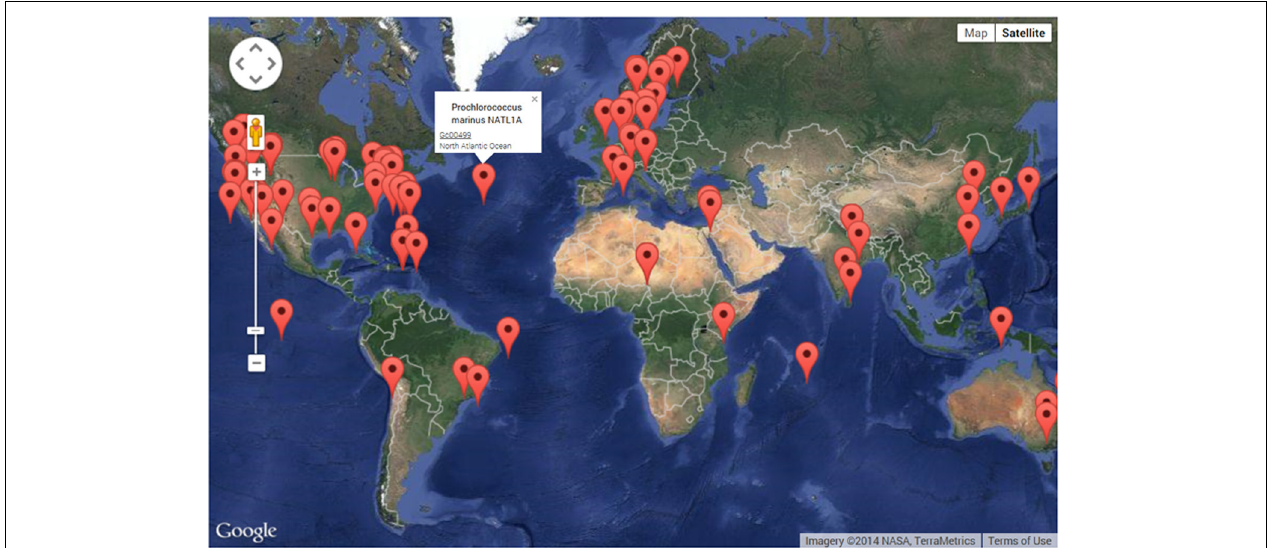
organism, genome characteristics (i.e., GC content, size), sequencing method used, specific coordinates of the origin of the strain, as well as links to external databases (as shown for Prochlorococcus marinus NATL1A). The GOLD also describes the status of each record in tabular format.